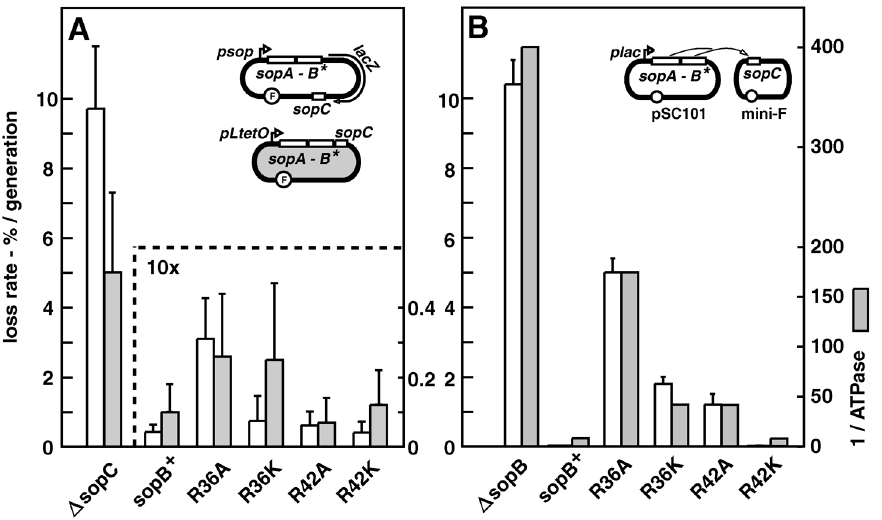
Figure 1. Effect of SopB R36 and R42 mutations on mini-F stability. A . sopAB operon and sopC in natural configuration ( cis ; see sketches): white bars - strain DLT1900 carrying pDAG218 and derivatives, grown at 30 u C in minimal-glycerol-leucine medium (t , 160 min); shaded bars - strain DH10B carrying pDAG173 and derivatives, grown in minimal-glycerol-Casamino acids medium (t , 80 min). Error bars are standard deviations of $ 3 loss-rate assays. Note 10-fold scale change for sopC + plasmids. B . sopAB and sopC on separate plasmids, pAM138 and mini-F respectively ( trans ), in strain MC1061 grown in minimal-glycerol-leucine medium: white bars – loss rates. Shaded bars show ATPase deficits as the inverse of ATPase stimulation by each SopB in vitro , determined previously [12].